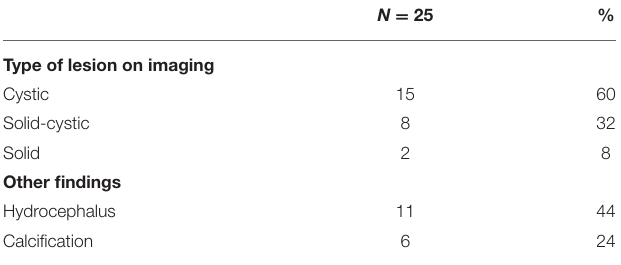
TABLE 3 | Imaging characteristics.